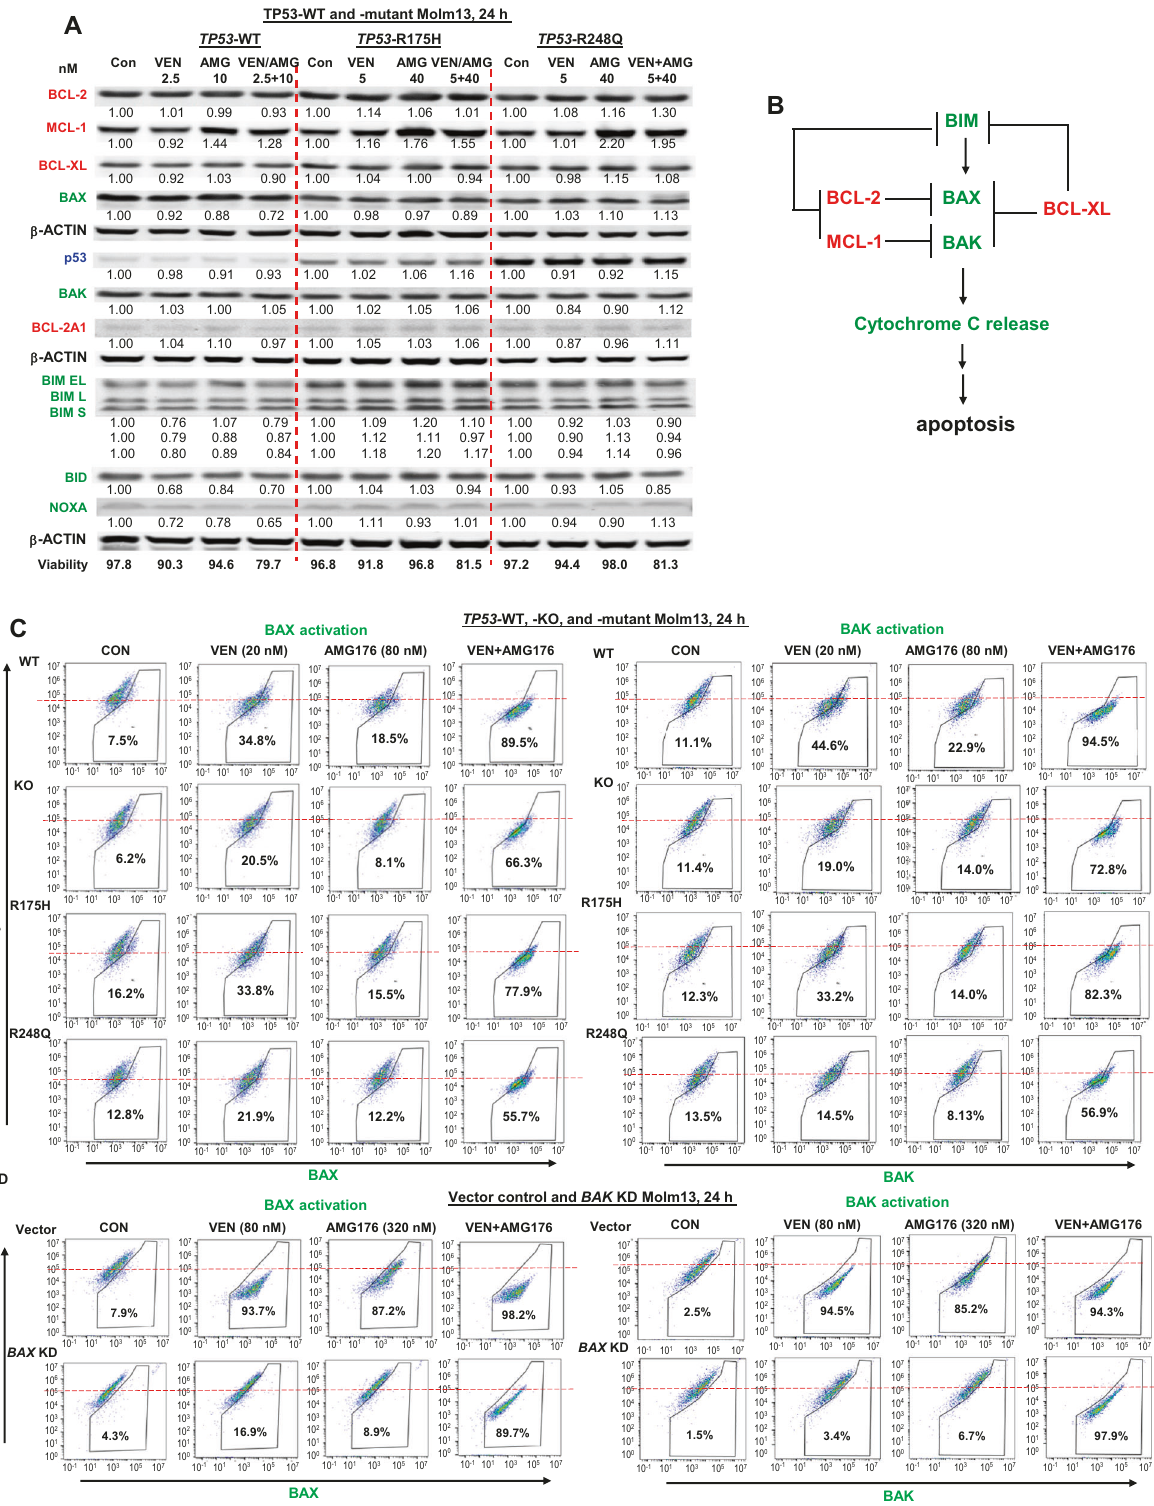
Fig. 3 The role of BCL-2 family members in BH3 mimetic – induced apoptosis. A TP53 -WT and -mutant (R175H and R248Q) Molm13 cells were treated with VEN, AMG176 (AMG), or both at the indicated concentrations for 24 h. Protein levels were determined by Western blot analysis. B Schematic of apoptosis induction requiring BAX and BAK activation, which is activated by BIM and blocked by BCL-2 and MCL-1. C , D TP53 -WT, -KO, or -mutant Molm13 cells ( C ) and vector control or BAX -KD Molm13 cells ( D ) were treated with VEN, AMG176, or both at the indicated concentrations for 24 h. BAX and BAK activation and cytochrome C release were measured by fl ow cytometry. h hour.